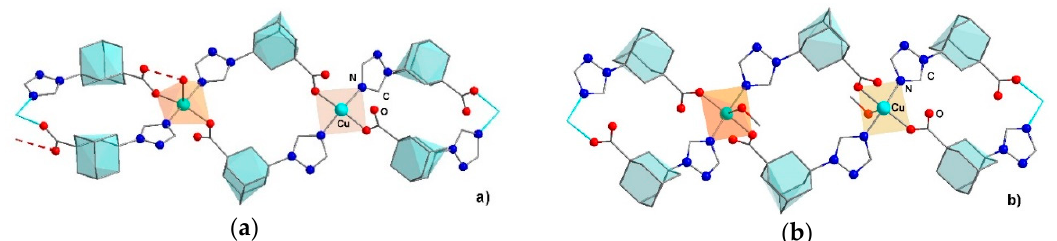
Figure 2. The structure of 1D chain of the complexes 1 ( a ) and 2 ( b ). Adamantane units are coloured blue, coordination polyhedra of the central atoms are coloured orange. Hydrogen atoms and solvate molecules are omitted; dashed red lines indicate intramolecular hydrogen bonds.